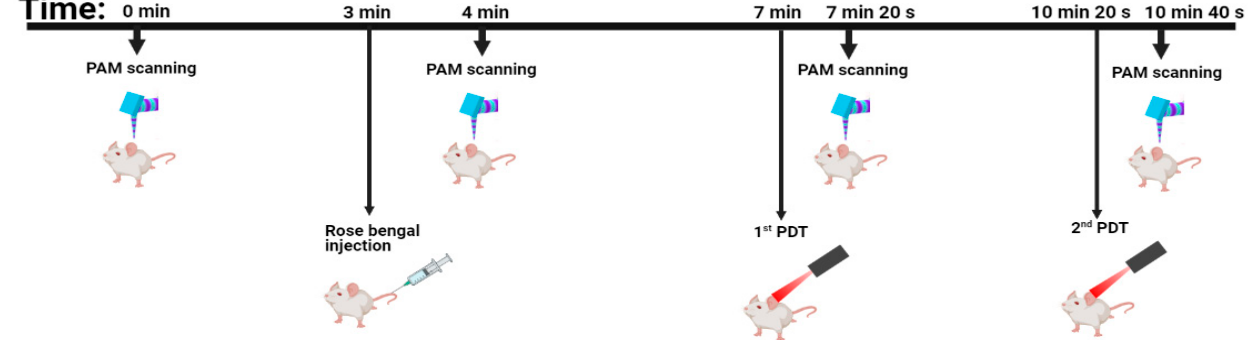
Figure 2. Protocol of the PAM-monitored melanoma PDT treatment.